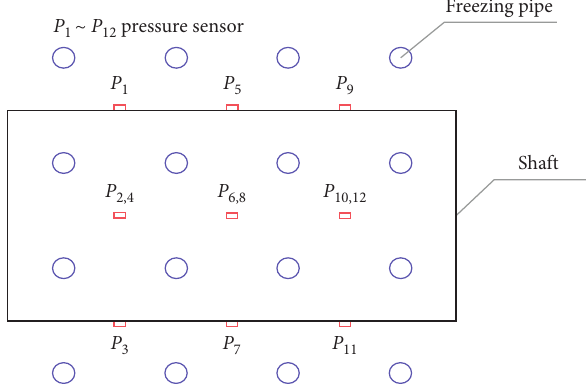
Figure 7: Pressure sensor measuring